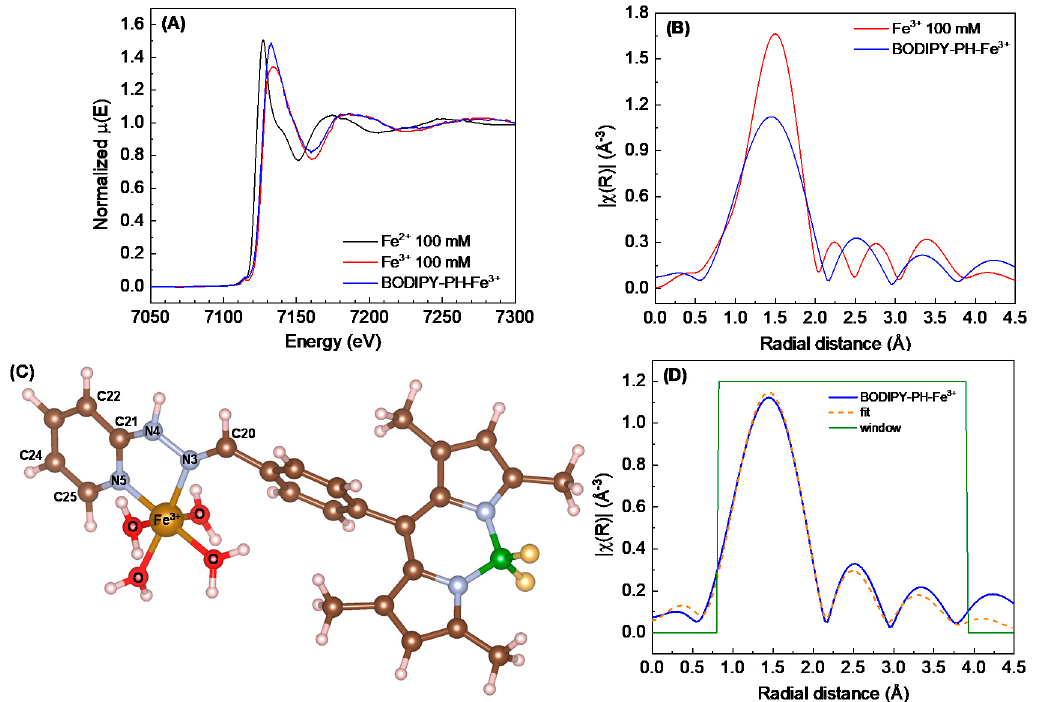
Figure 13. ( A ) X-ray absorption near edge structure (XANES) spectra probed at Fe K-edge of the mixture between BODIPY- PH ligand and Fe 3+ (BODIPY-PH-Fe 3+ ) compared to the 100 mM standard solutions of Fe 2+ and Fe 3+ in acetonitrile-water (1:9 v/v ). ( B ) Comparison of the extended X-ray absorption fine structure (EXAFS) data of the BODIPY-PH-Fe 3+ with respect to the one of 100 mM standard solutions of Fe 3+ . ( C ) The DFT-calculated structural model of BODIPY-PH-Fe 3+ used for EXAFS fitting indicating the neighboring atoms around Fe 3+ . ( D ) EXAFS data fitting by employing ARTHEMIS software of the BODIPY-PH-Fe 3+ .